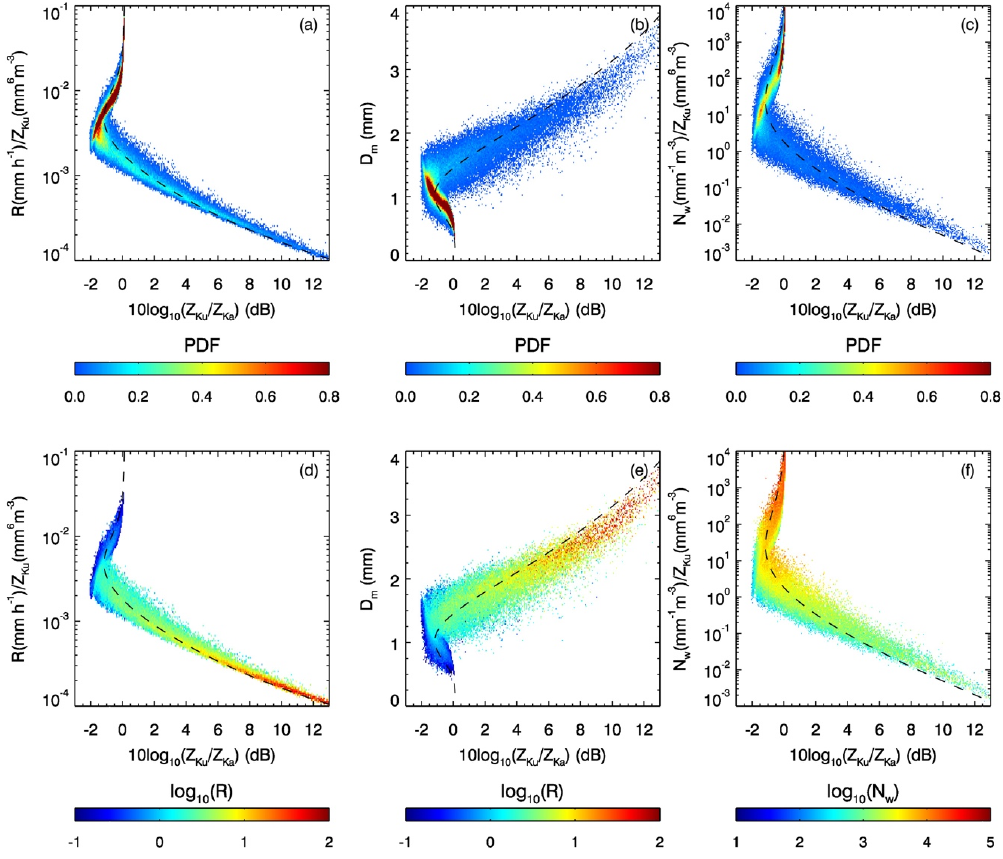
Figure 7. PDFs of the data obtained from the measured DSD in the planes of the R / Z Ku –DFR (dual-frequency ratio) ( a ), D m –DFR ( b ), and N w / Z Ku –DFR ( c ). Also shown are the images of the averaged R in the planes of the R / Z Ku –DFR ( d ) and D m –DFR ( e ) and the image of the -averaged N w in the plane of the N w / Z Ku –DFR ( f ). The computational results from the gamma DSD model with µ = 3 (black dashed lines) are